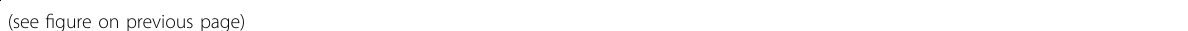
Fig. 2 Genetic and pharmacological inhibition of BCL-X L preferentially impairs MPM cell proliferation. A-C Immunoblots ( A ) and micrographic images ( B ) of LP-9 and MPM cells with siRNA-based BCL2L1 knockdown. Viable cells were counted 48 h post-transfection by trypan blue dye exclusion ( C ). Data were presented as mean ± s.d. ( n = 3). **** p < 0.0001 by two-way ANOVA with Tukey ’ s multiple comparisons test. Scale bar: 50 μ m. D Flow cytometry-based apoptotic assay of LP-9 and MESO-1 cells 48 h post-transfection with siRNAs. Shown on the right is fold change